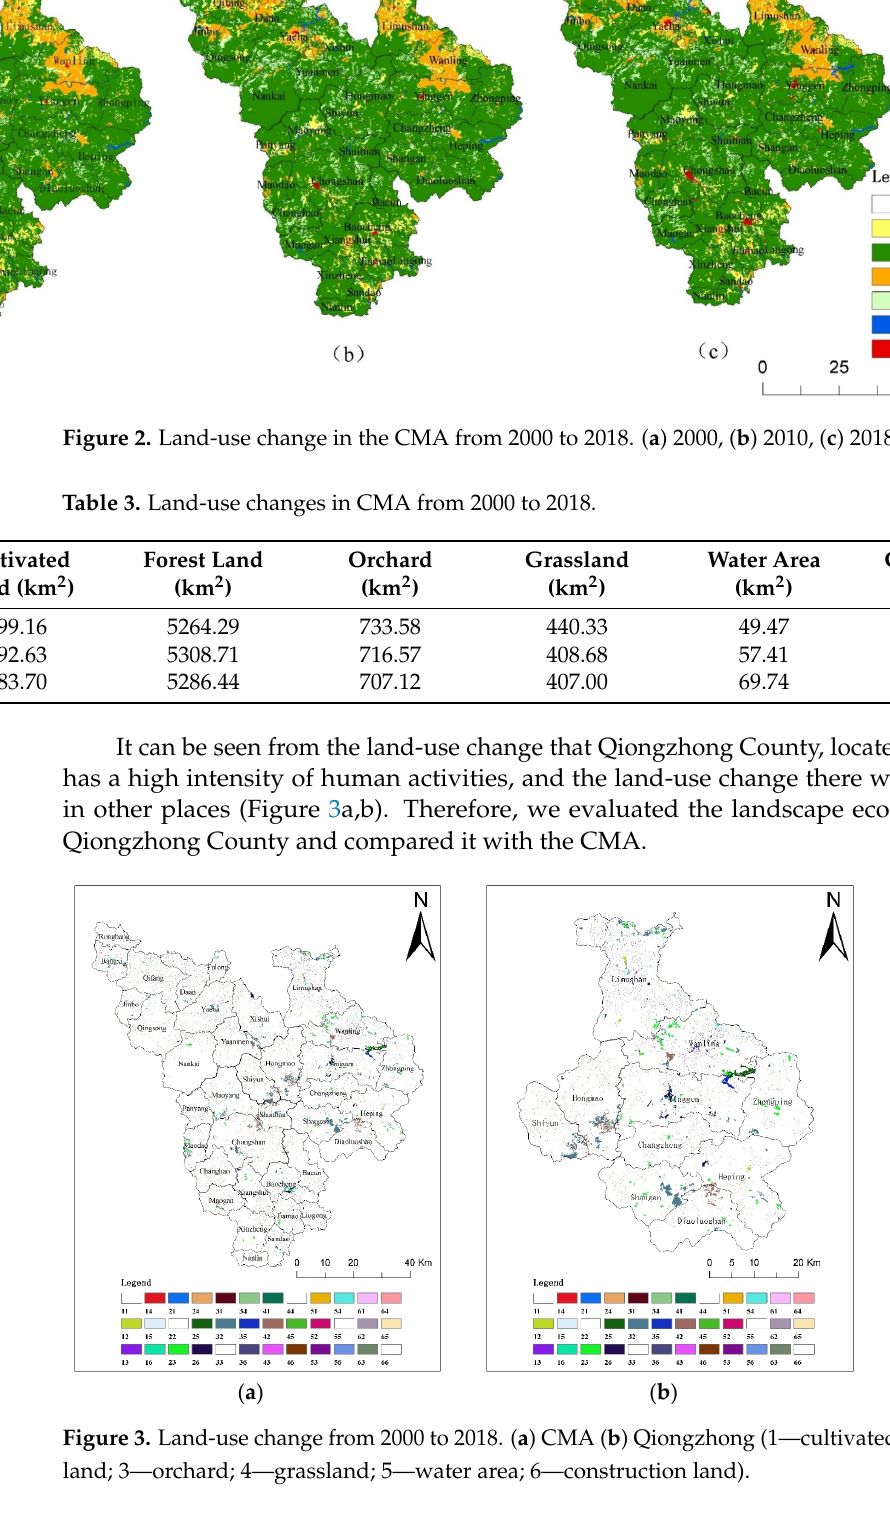
Table 3. Land-use changes in CMA from 2000 to 2018.